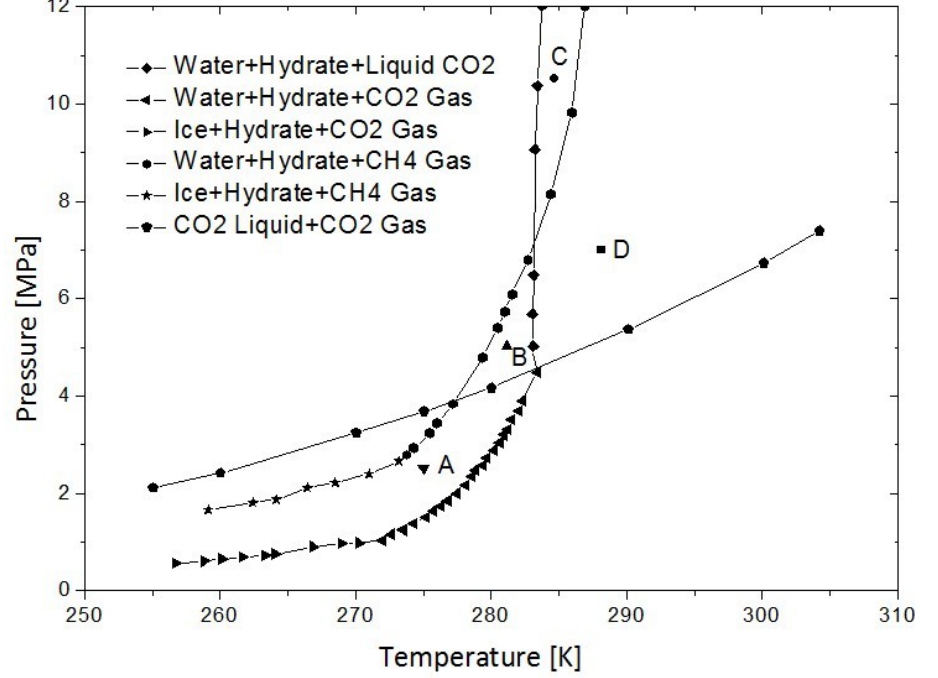
-CO -H O phase 4 2 2